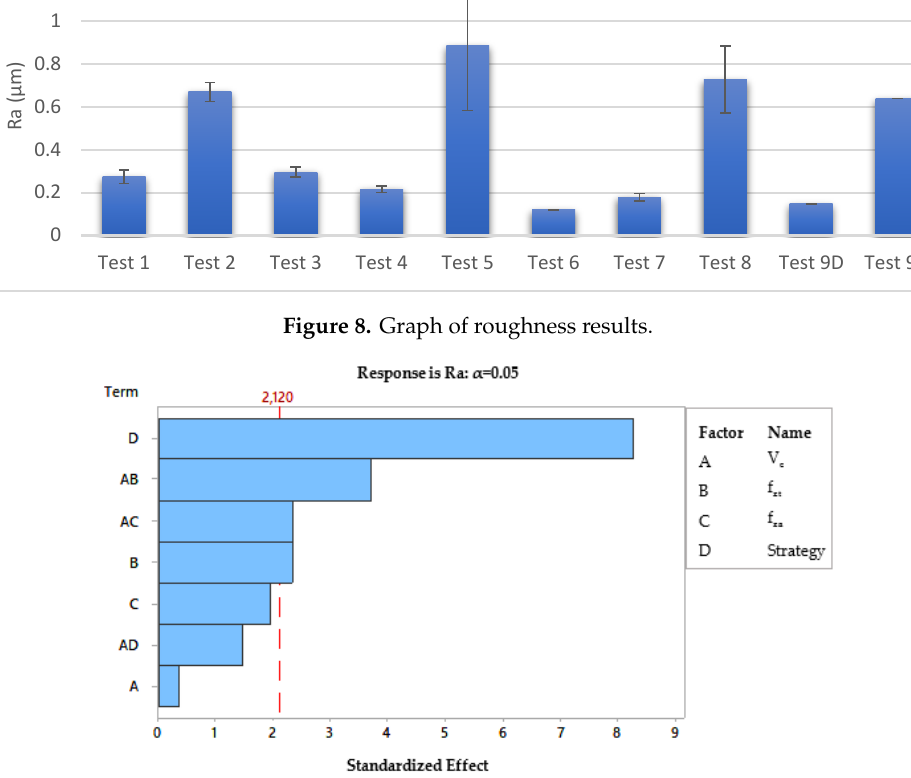
Figure 9. Pareto chart of the standardized effects for Ra.